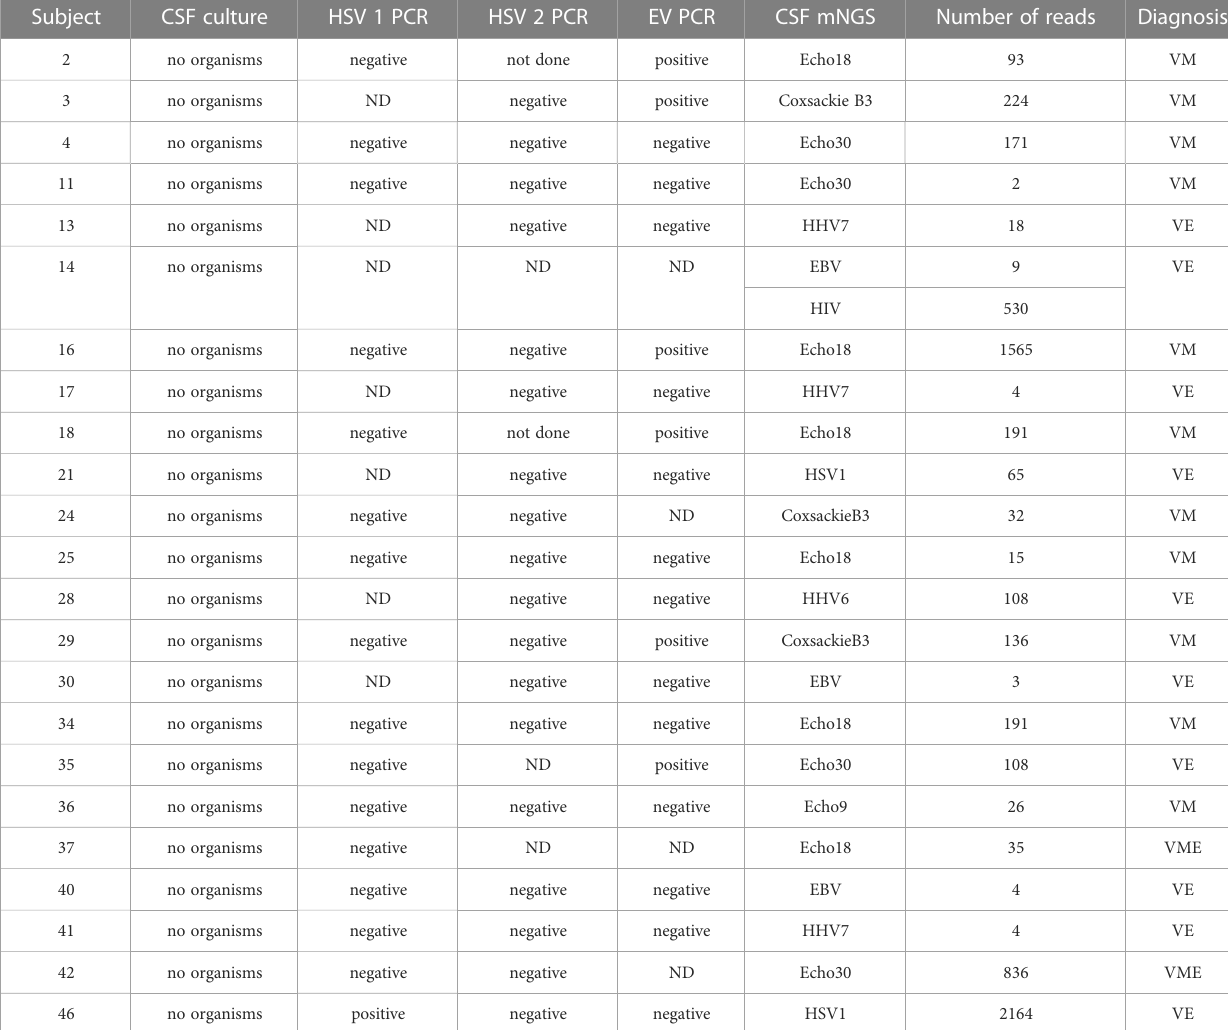
TABLE 2 Presentation of subjects for which CSF testing was positive by any